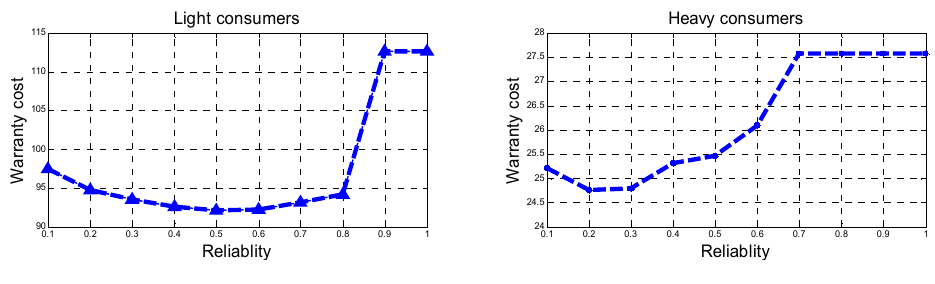
Figure 3. Optimal PM.